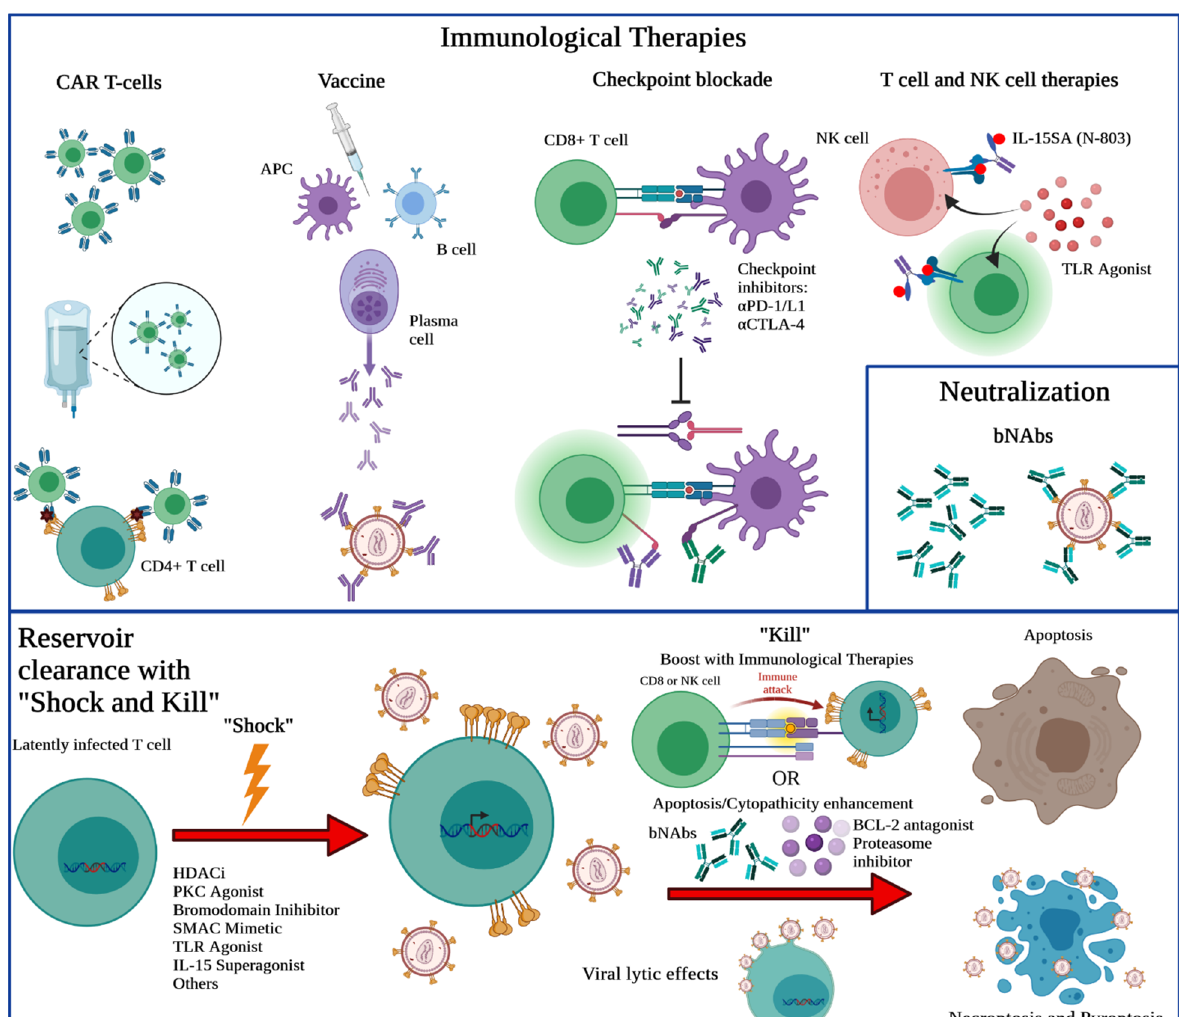
Figure 3. Cure strategies focusing upon clearance of the latent reservoir. There are many different therapeutics that are being investigated for HIV cure. CAR T-cells are engineered with chimeric receptors to better respond to virally infected cells and eliminate them. Vaccines can induce B cell production of antibodies against virus, but also T-cell responses to help clear the infected cells. PD-1/L1 and CTLA-4 are suppressors of T-cell activation and by blocking these interactions, there can be increased T-cell activation. Il-15 superagonist and TLR agonists can be administered to individuals to bolster the cell-mediated immune response. Broadly neutralizing antibodies (bNAbs) can be directly administered to neutralize virus. Of note, eradication of the latent HIV reservoir and establishment of potent immune responses may result in eventual functional or sterilizing cure and will likely require combination approaches as shown in this schematic with various potential drugs, small molecules, or interleukins as treatment.